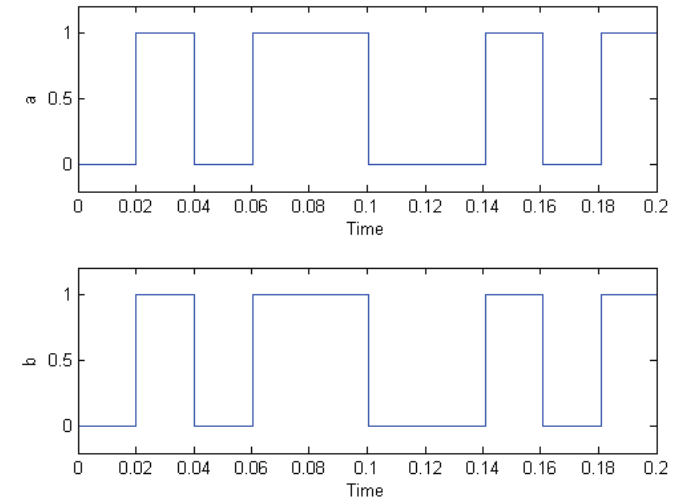
Figure 6. The block diagram of the acquisition loop of the receiver.